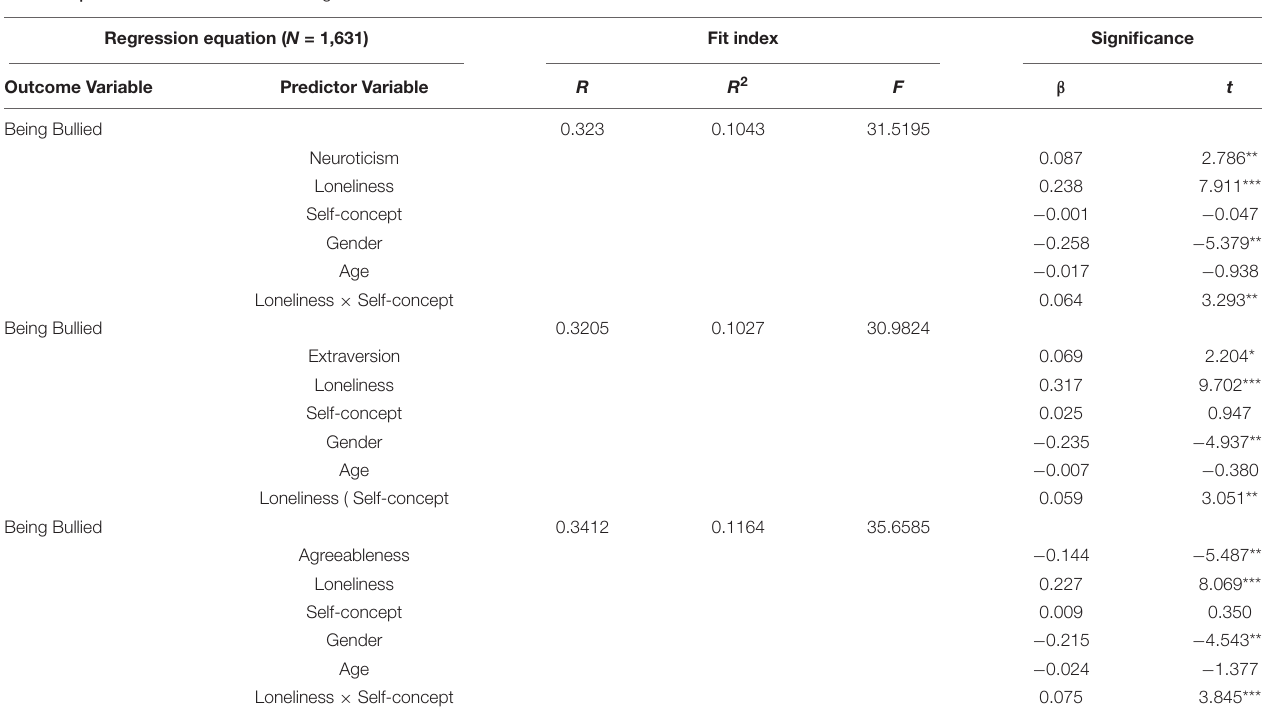
SE, standard error; LLCI, lower limit confidence interval; ULCI, upper limit confidence interval. TABLE 4 | Test of the moderated mediating